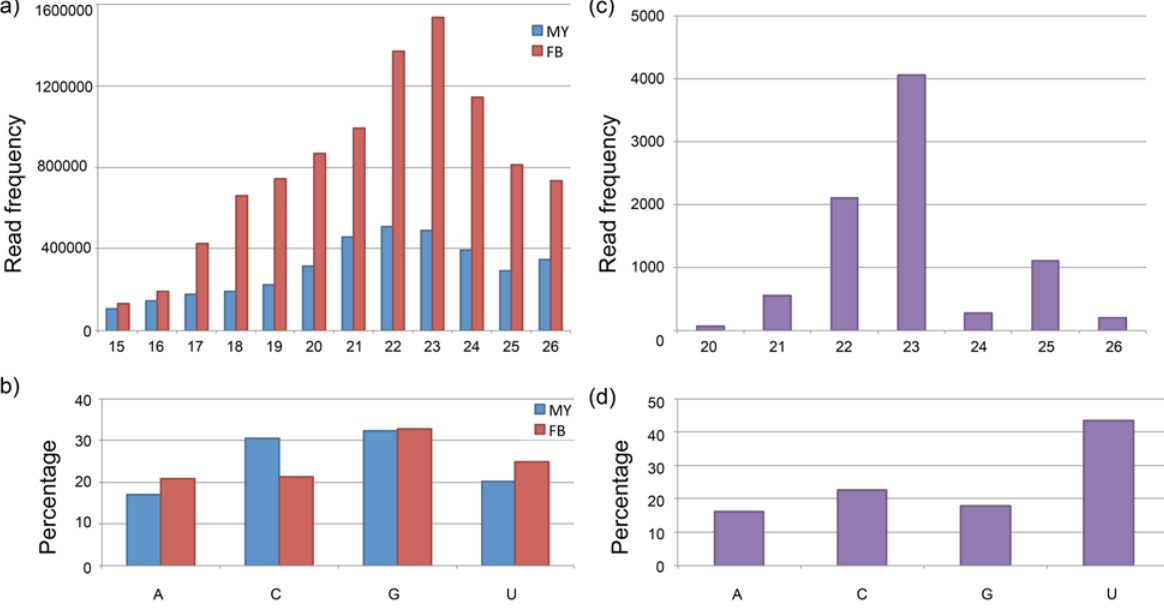
Fig 3. General features of the sRNAs and predicted miRNA in A . cinnamomea . (a) length distribution of total clean reads of sRNA library from MY and FB, (b) 5 0 end nucleotide frequency of sRNAs from MY and FB, (c) length distribution of predicted novel milRNAs, (d) 5 0 end nucleotide frequency of predicted novel